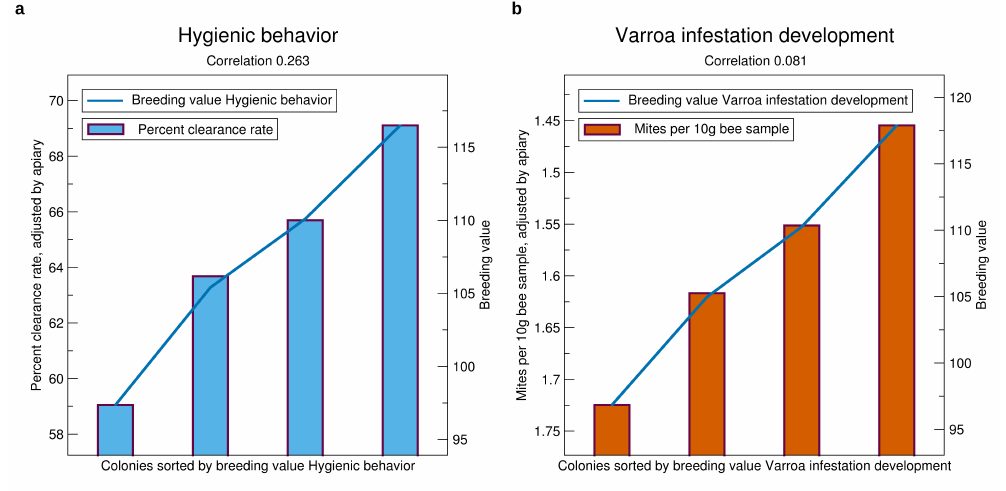
Figure 8. Comparison of prospective breeding values of queens tested in a year, iterated from 2014 to 2019, to the phenotypes standardized to an average apiary, see Section 2.3. ( a ) Hygienic behavior, ( b ) VID. Significances of correlations for hygienic behavior are p < 10 − 16 , for VID p < 0.0037. The standard errors are about 15 percent points in clearance rate and 1.5 for